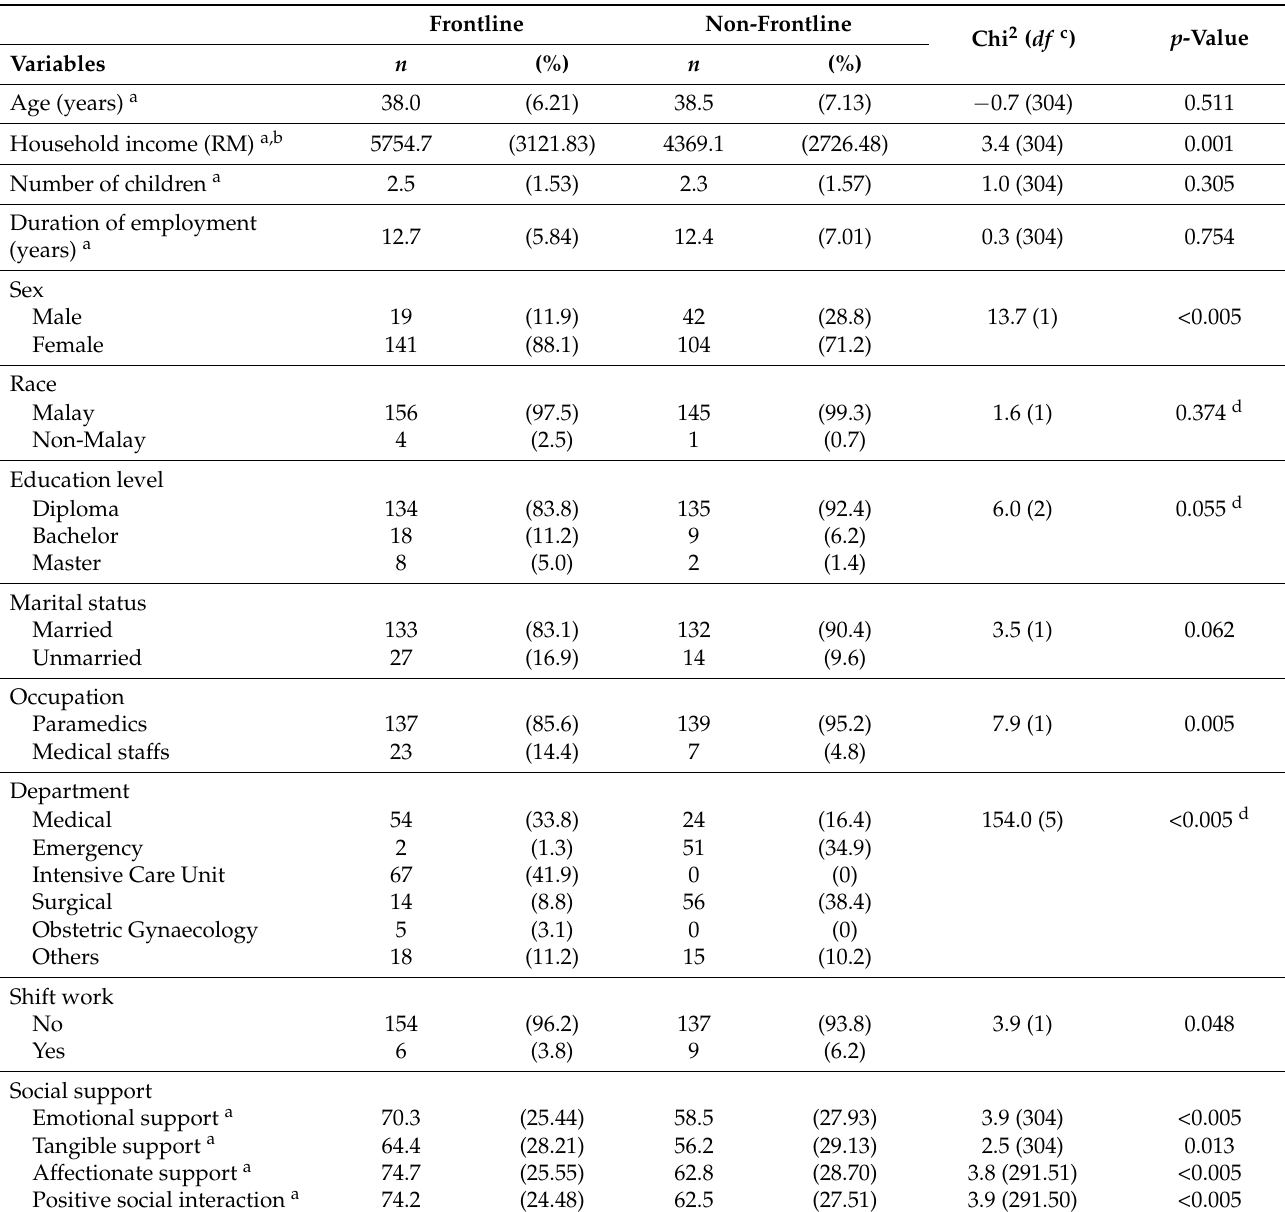
Table 1. Socio-economic characteristics of healthcare